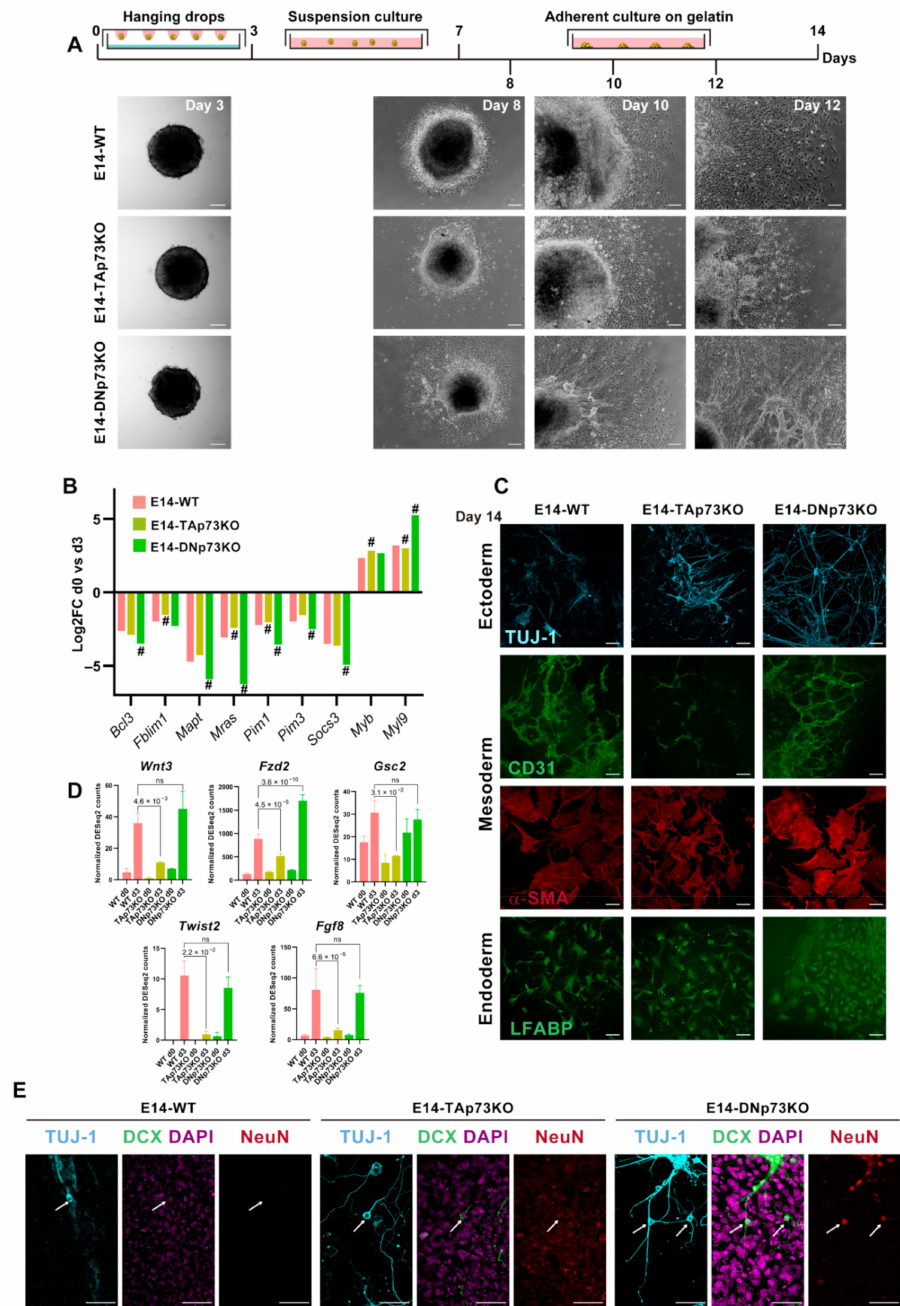
Figure 8. Inactivation of p73-isoforms compromises adequate lineage differentiation accelerating neural differentiation. ( A ) Schematic diagram of the spontaneous 2D-differentiation protocol and representative images of the EBs at different time points. Images were acquired by stereomicroscopy (day 3; scale bar: 100 µ m) or phase-contrast microscopy (days 8-12; scale bar: 250 µ m). ( B ) Fold-changes in expression of genes regulated during the early stages of the spontaneous differentiation process of mESCs, comparing day 0 with day 3. # Denotes statistically significant p-adj values. ( C ) Confocal microscopy images showing differentiation to the three germ layers: TUJ-1 (ectoderm, blue), CD31 and α -SMA (mesoderm, green and red, respectively) and LFABP (endoderm, green). Scale bar 50 µ m. ( D ) RNA-seq analysis of mesodermal related genes showed a significant abatement in TAp73KO cells. Bar graphs depicts normalized DEseq2 counts. p-adj values are indicated. ( E ) Confocal microscopy images showing markers of neural differentiation: TUJ-1 (blue), Doublecortin (DCX, green) and NeuN (red). Nuclei were stained with DAPI (purple). White arrows show neuronal cell bodies. Scale bar 50 µ